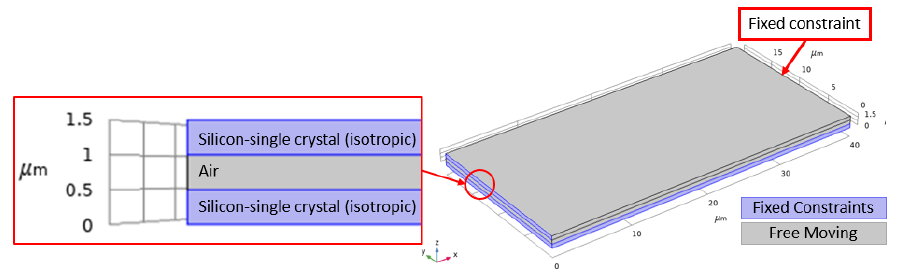
Figure 11. COMSOL Multiphysics ® software simulated microbridge geometry with a length and width of 40 µ m and 20 µ m, respectively. The top and bottom layers are composed of silicon-single crystal (isotropic) and the middle layer, which forms the cavity is an air domain. The top electrode, air cavity and bottom electrode each have a thickness of 0.5 µ m. Boundaries shown in blue are fixed while the grey boundaries are free to